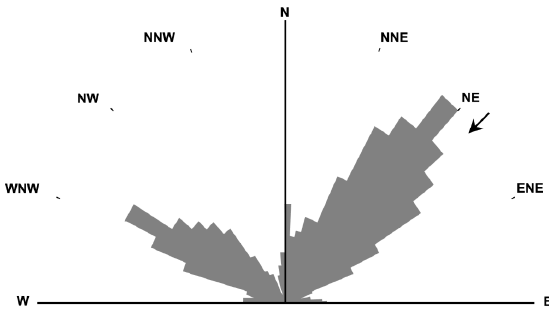
Figure 14. Rose diagram for the final lineament map.